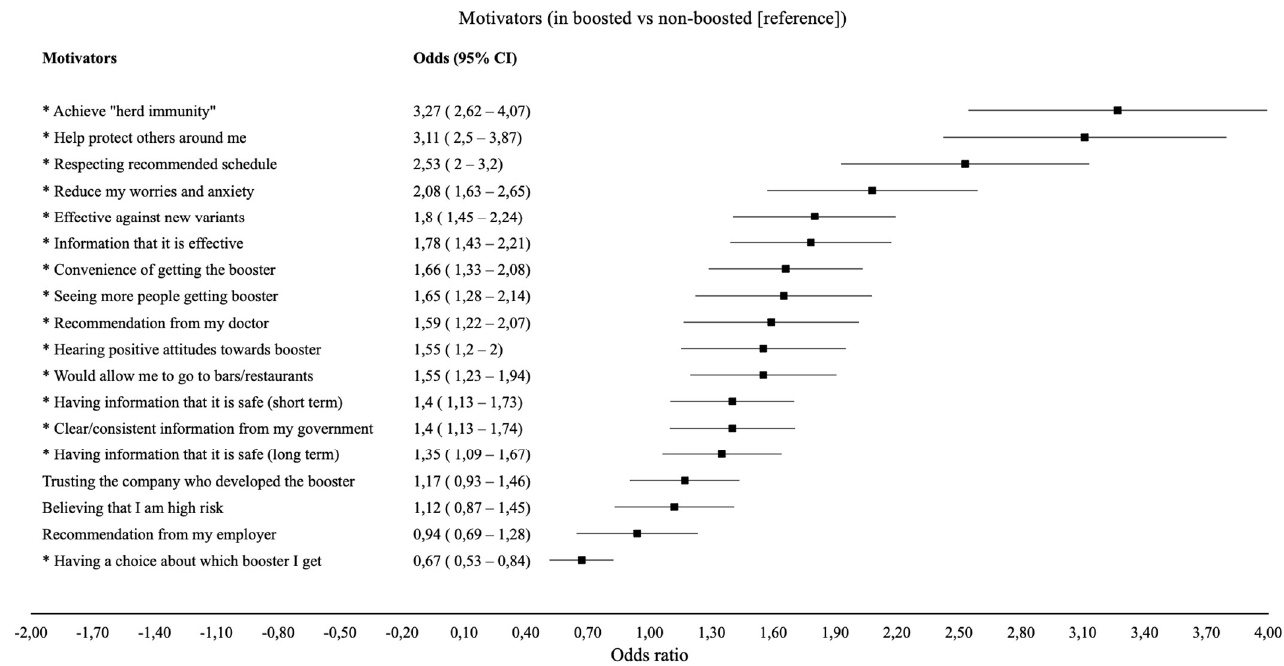
Figure 2. Adjusted * odds ratio for reporting each motivator “to a great extent” as a function of booster vaccination status in boosted vs non-boosted (reference), * = sign.